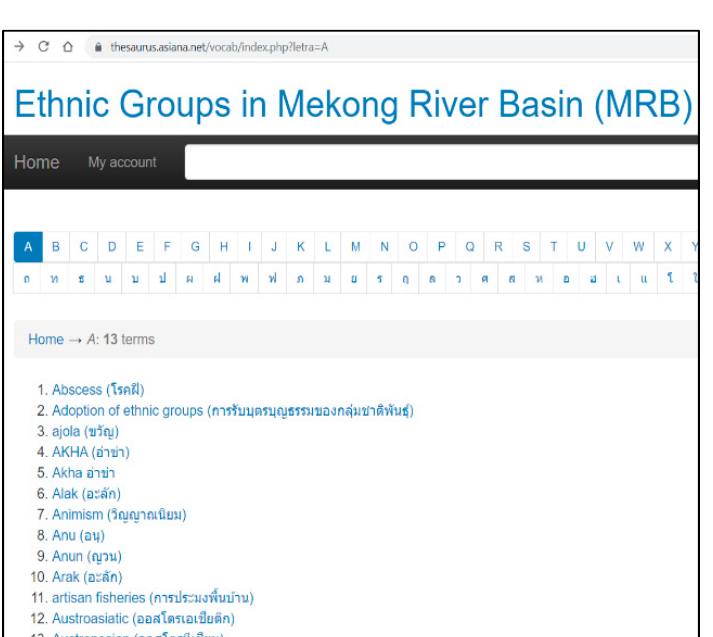
Figure 5. Web access of the digital thesaurus of ethnic groups in the MRM, showing a list of terms begin with A.